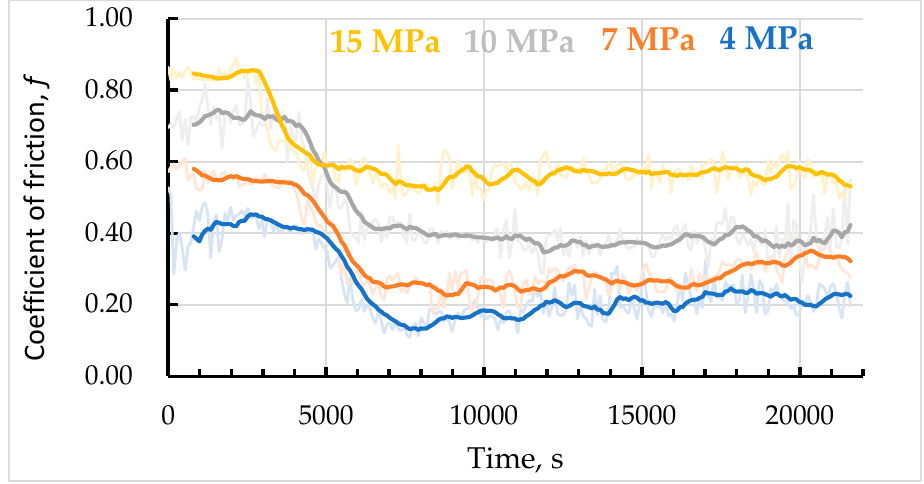
Figure 8. Coefficient of friction of the alloy samples tested at 4, 7, 10, and 15 MPa. Table 4. Values of the coefficient of friction measured during the wear test and wear loss.